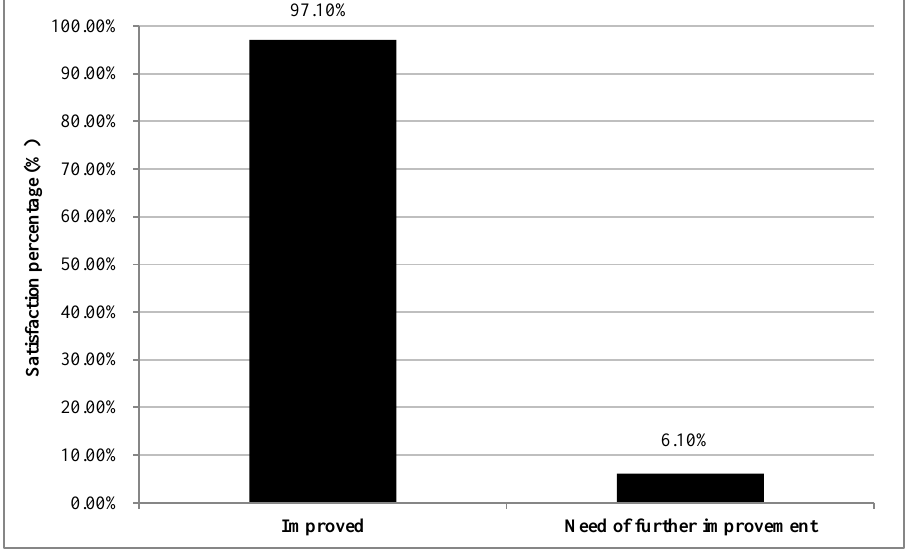
Figure 5. Quality of services after QMS